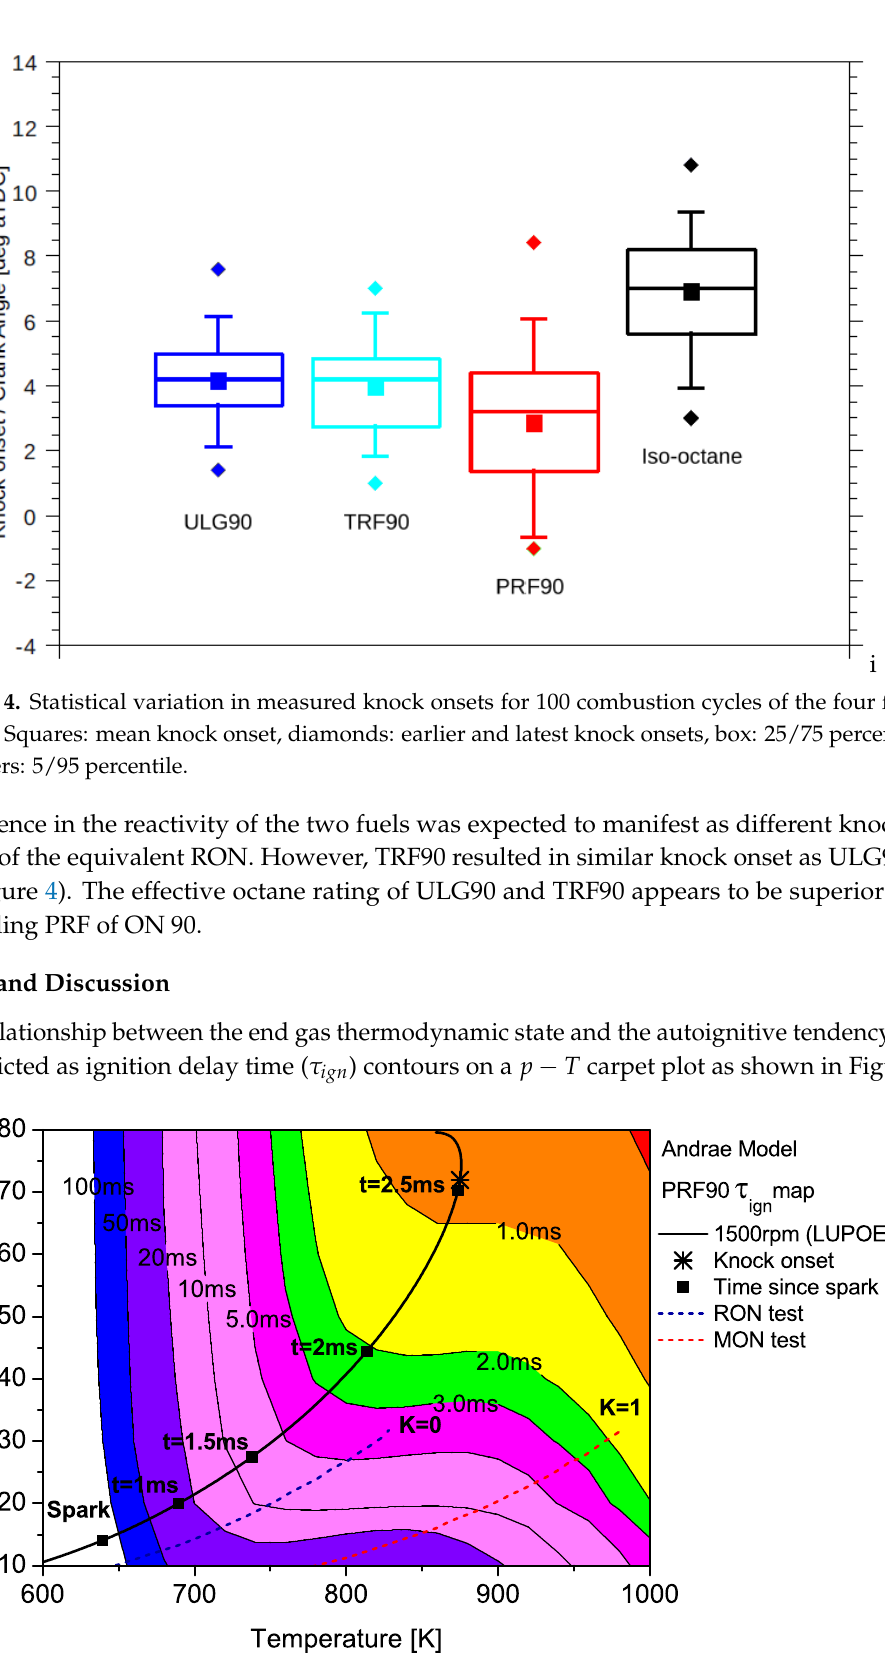
Figure 5. The τ ign contour map of PRF90 as predicted by the Andrae model superimposed with the unburned zone p − T history of LUPOE2-D and typical RON/MON